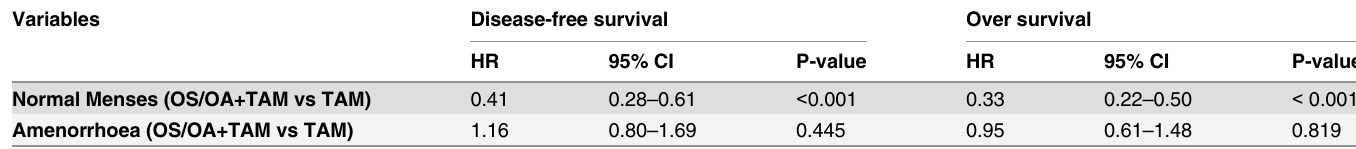
Table 3. Multivariate analysis of disease-free survival and overall survival in patients with OS/OA or